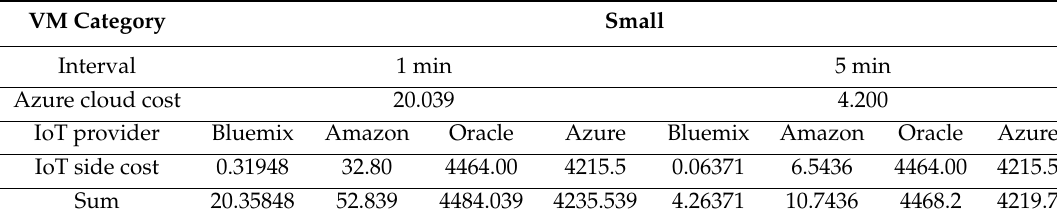
Table 3. IoT costs with a small VM category in scenario N o 3.